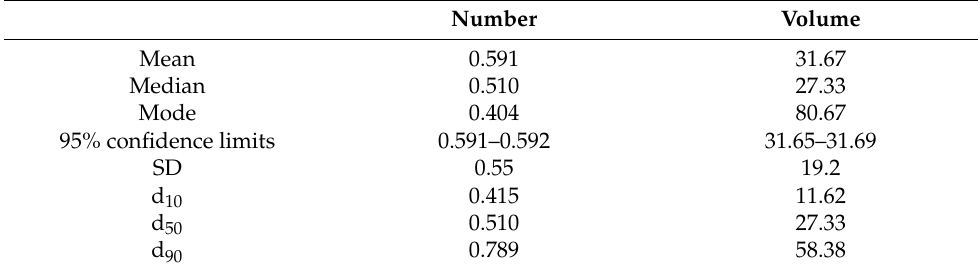
Table 1. Statistical data of the tests. All values in µm.